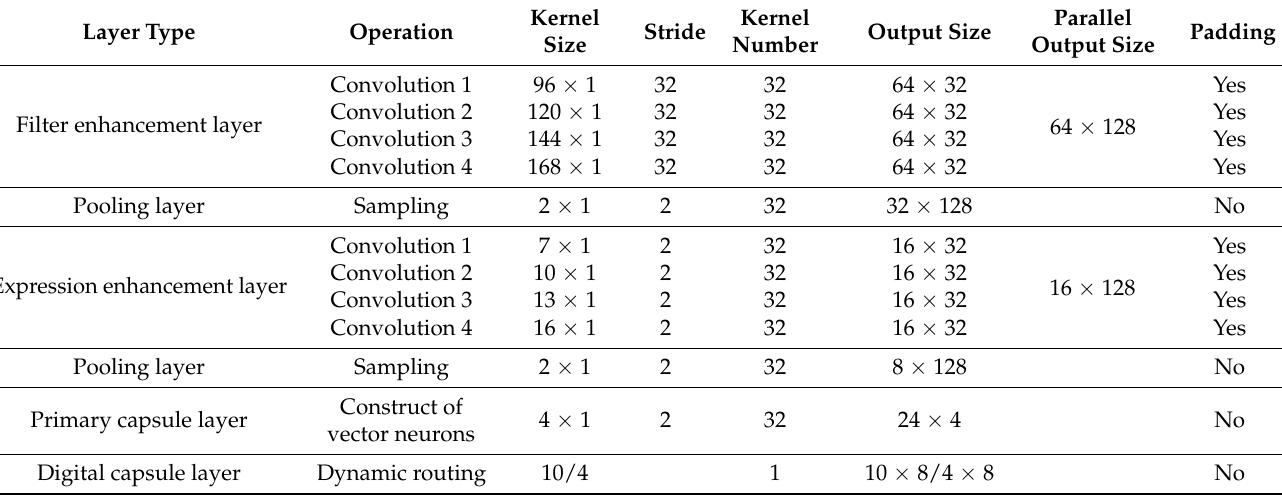
Table 3. The network parameters of